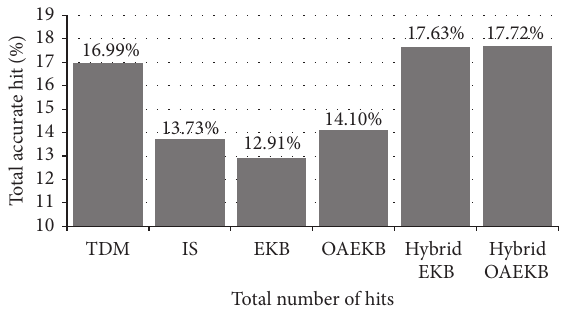
Figure 12: Total number of accurate hits at threshold 𝑔 = 45 .